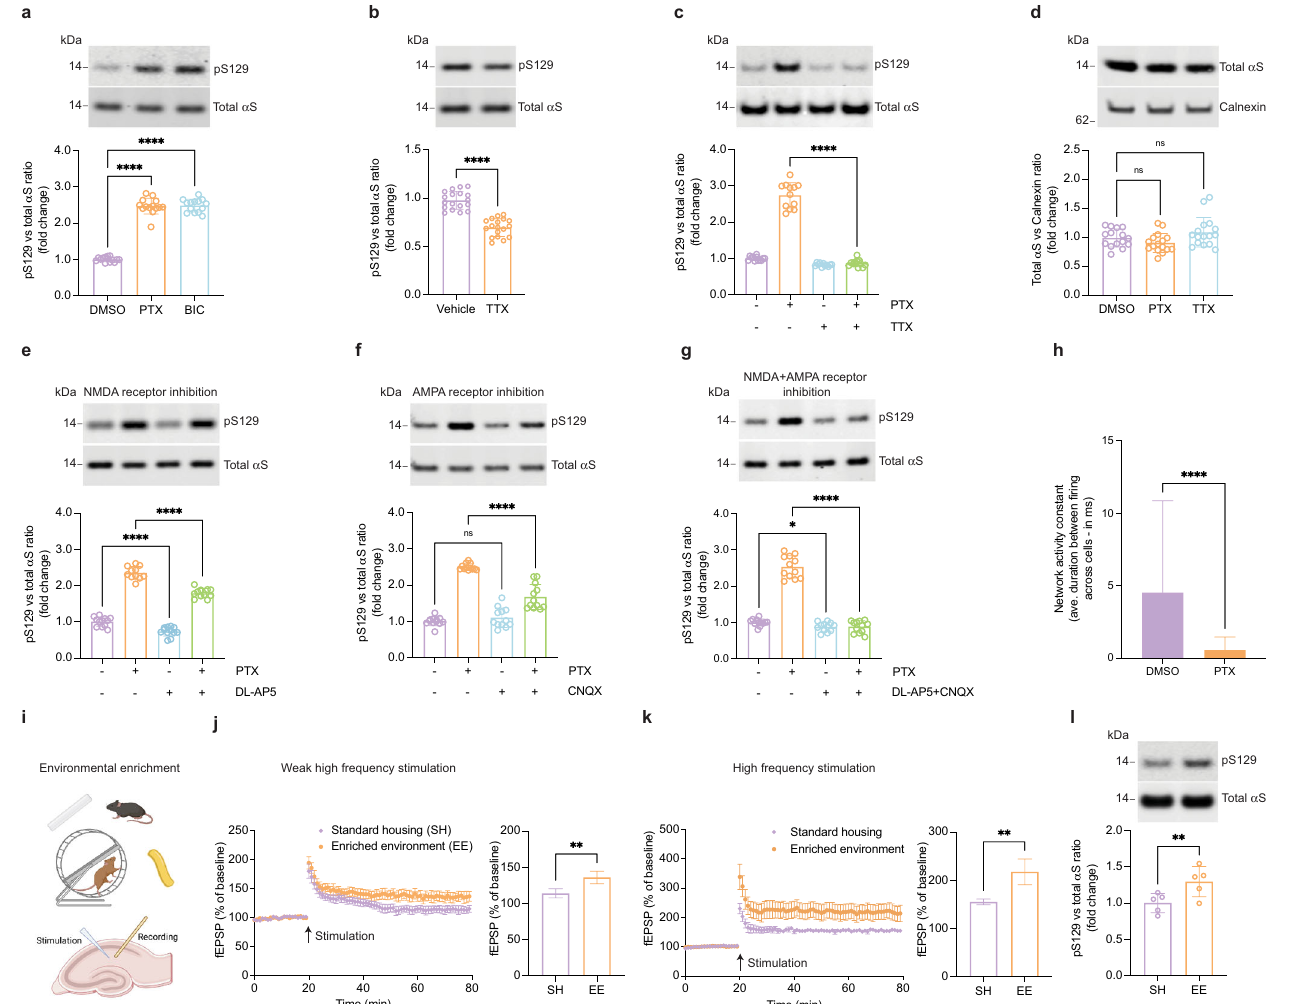
Fig. 1 pS129 correlates with neuronal activity. a DIV17 – 21 rat cortical neurons treated with the GABA A receptor antagonists picrotoxin (PTX, 20 µM) or bicuculline (BIC, 20 µM) for 2 h. WB for total α S and pS129. N = 3 independent experiments on different days, n = 14 biological replicates total. **** p < 0.0001. Mean + / − SD. Brown-Forsythe and Welch ANOVA with Dunnett ’ s T3 post hoc test for multiple comparisons. b DIV17-21 rat cortical neurons treated with vehicle or the sodium channel blocker tetrodotoxin (TTX, 1 µM). WB for total α S and pS129. N =